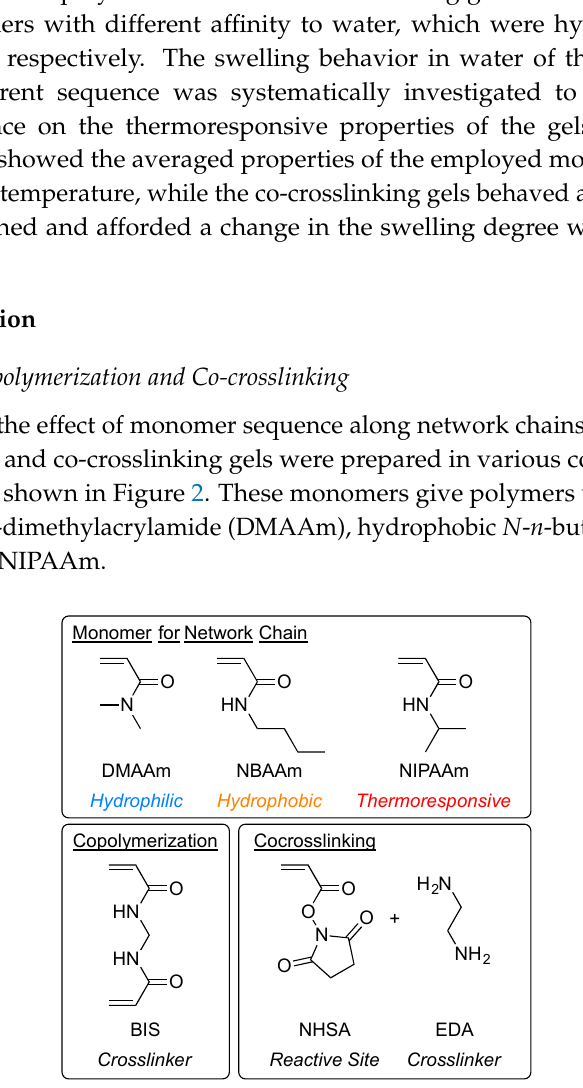
Figure 2. Chemical structure of monomers and crosslinkers for the synthesis of copolymerization and cocrosskinking gels. DMAAm = N , N -dimethylacrylamide; NBAAm = N - n -butylacrylamide (NBAAm); NIPAAm = N -isopropylacrylamide; BIS = N , N’ -methylenebisacrylamide; NHSA = N -(acryloyloxy)succinimide; EDA = ethylenediamine.